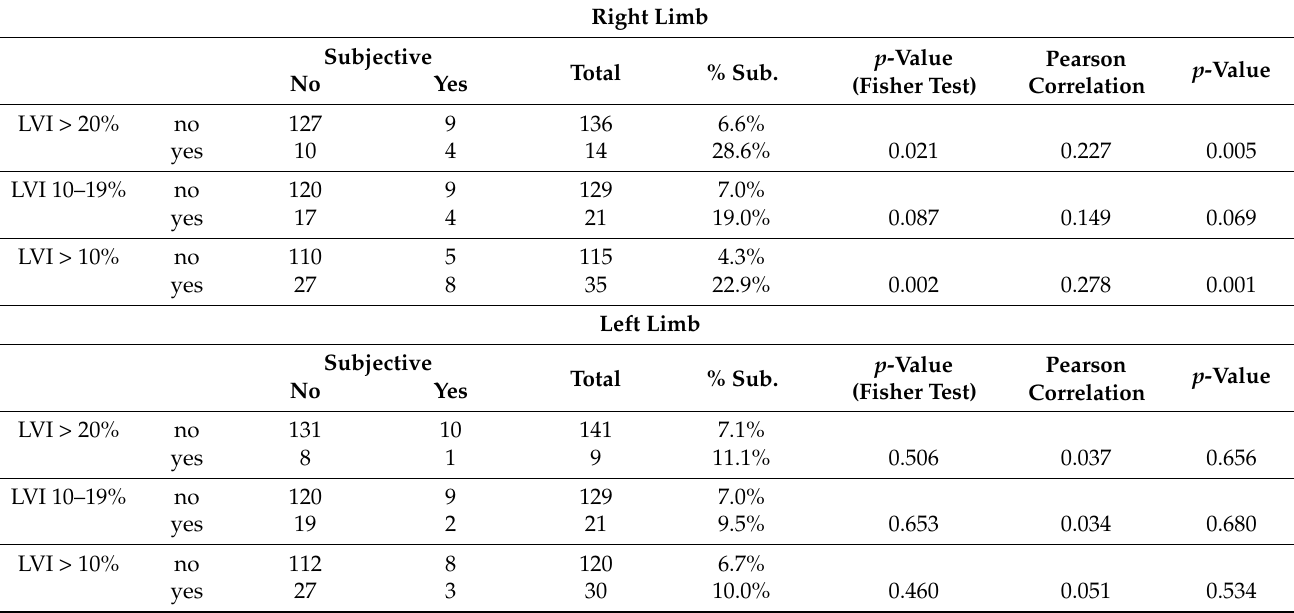
Table 2. Correlation between subjective and objective LLL